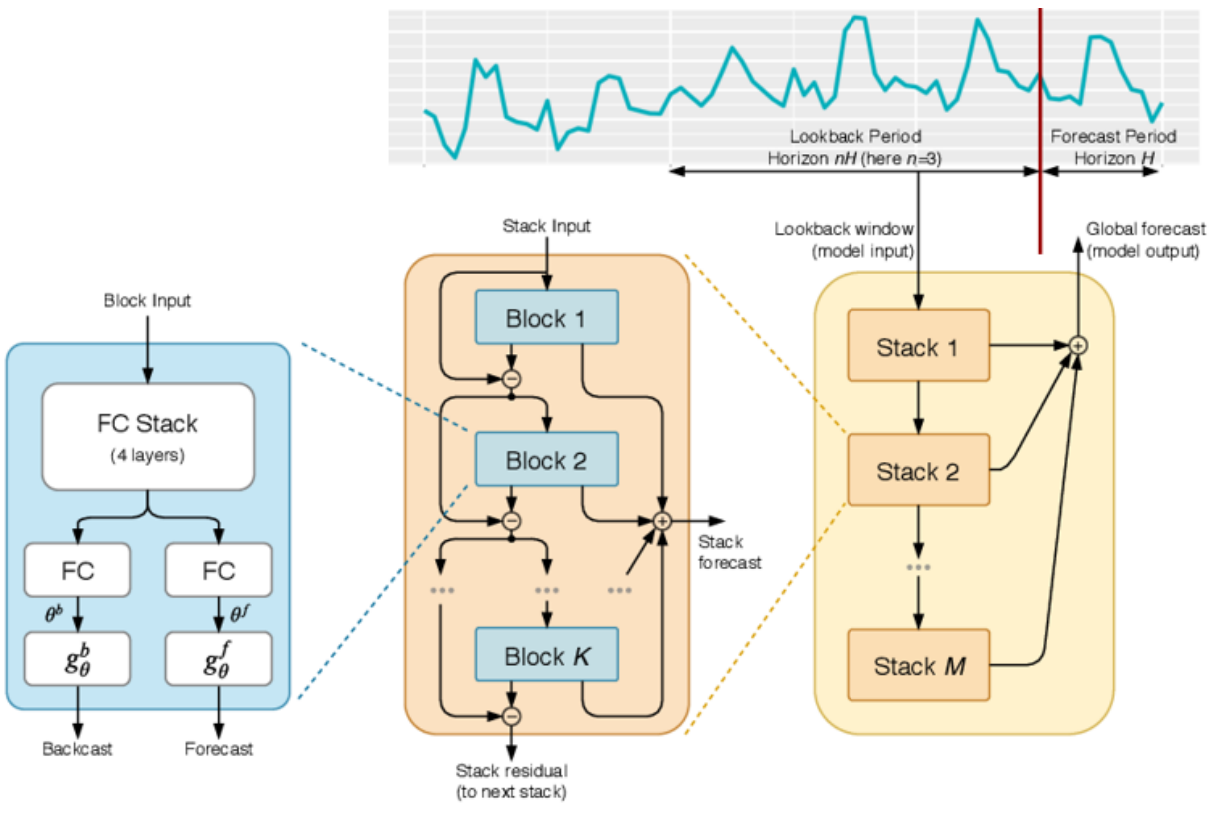
Figure 2. N-BEATS architecture (Reprinted from ref. [27]).